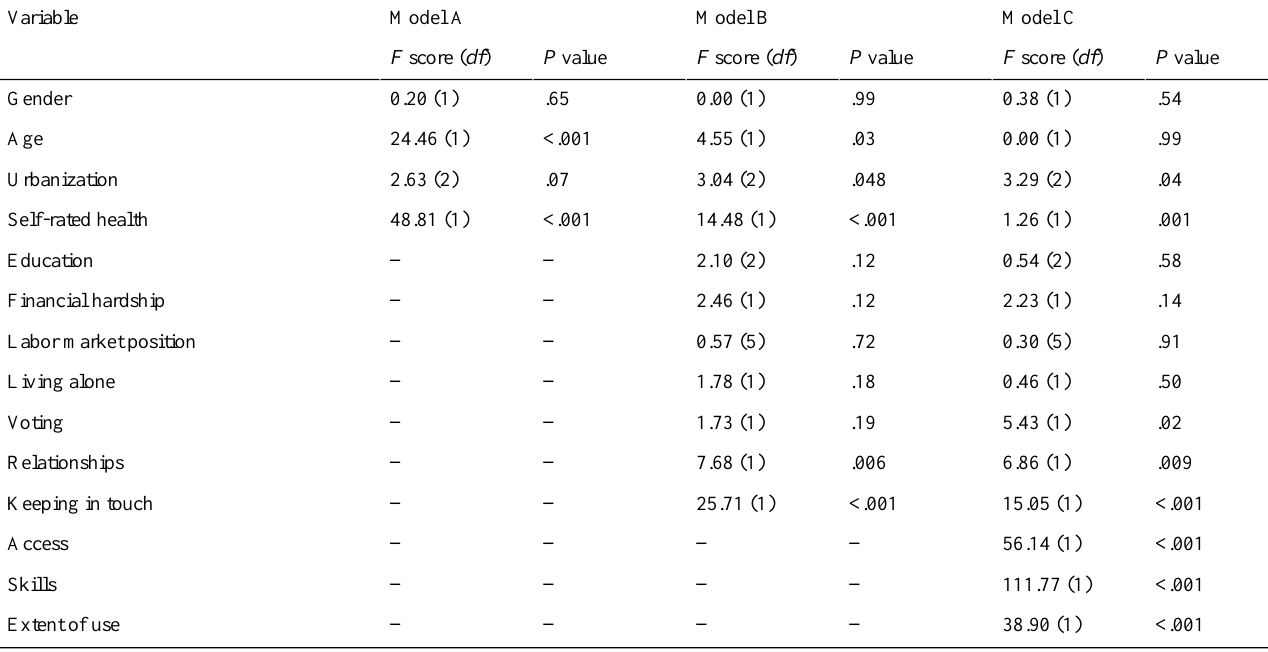
Table 4. The association of explanatory factors with perceived collaboration benefits (analysis of covariance, n=4495).